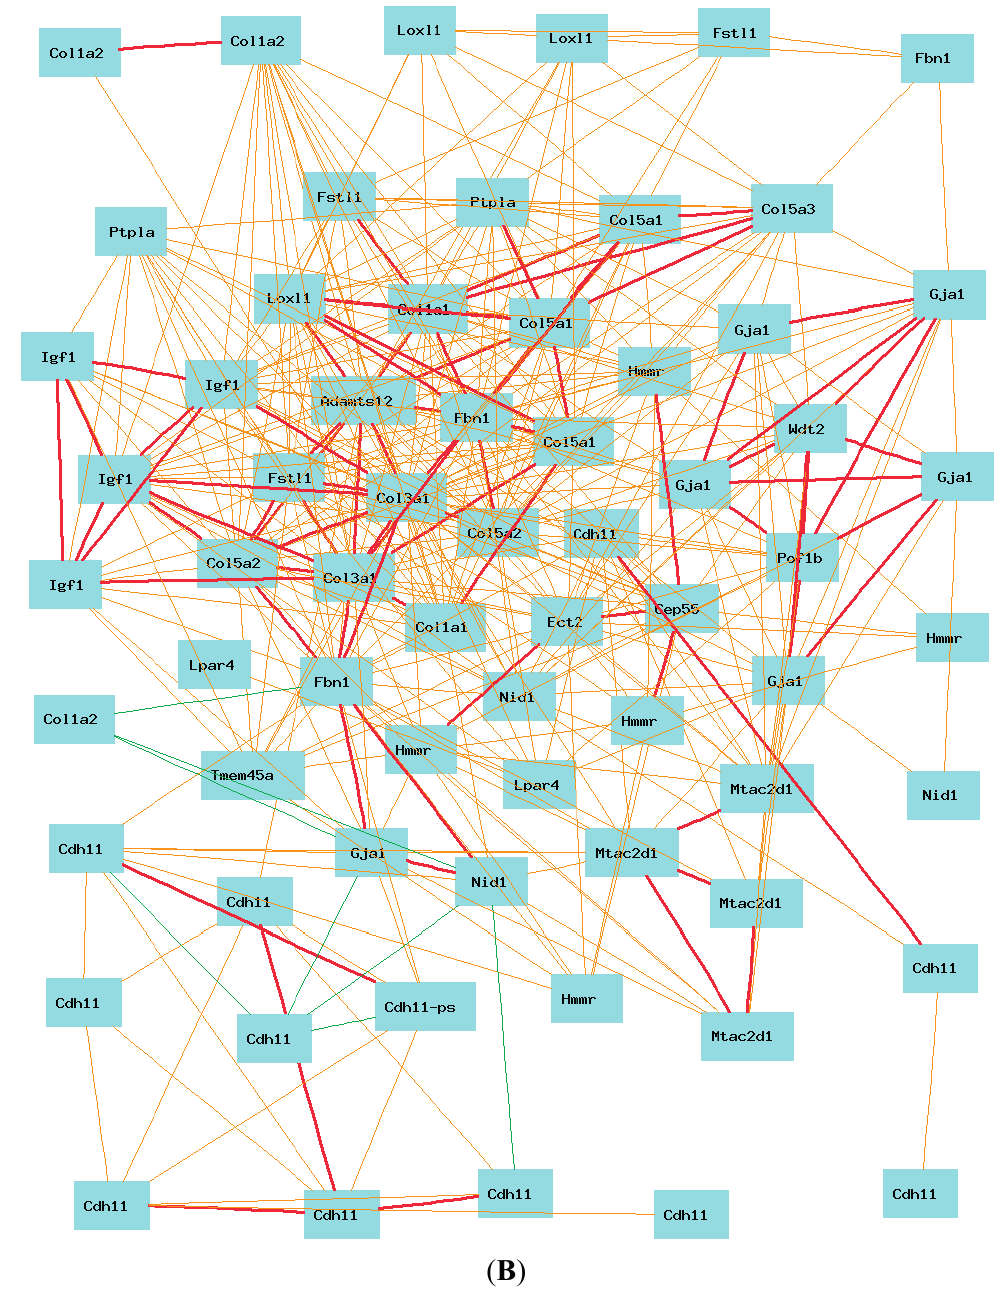
Figure 4. ( A ) Gene network of 44 common genes from two probes. The 46 nodes in the graph below show the selected probes. Only nodes with edges are displayed. The 866 edges between the nodes, filtered from the 1035 total edges and drawn as curves, show Pearson correlation coefficients greater than 0.35 or less than − 0.35. The graph’s canvas is 40.0 by 40.0 cm, and the node labels are drawn with a 14.0 point font, and the edge labels are drawn with a 14.0 point font; ( B ) Two probes of Col3a1 show their positive correlation with 22 genes in mice. The 74 nodes in the graph below show the selected genes. Only nodes with edges are displayed. The 431 edges between the nodes, filtered from the 2701 total edges and drawn as lines, show Pearson correlation coefficients greater than 0.5 or less than − 0.5. The graph’s canvas is 40.0 by 40.0 cm, and the node labels are drawn with a 14.0 point font, and the edge labels are drawn with a 14.0 point